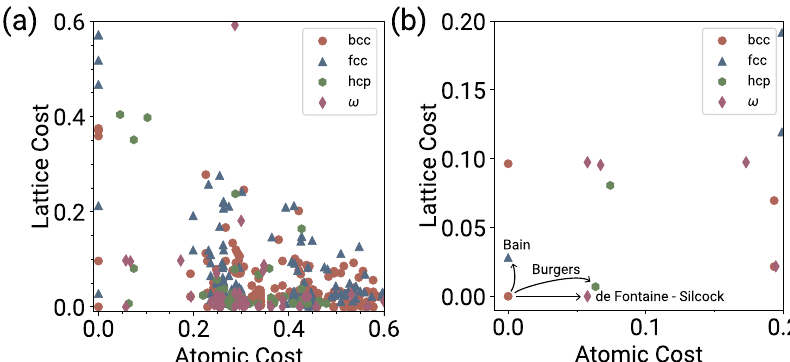
Fig. 5 Mapping costs of common structures onto bcc. The lattice and atomic costs when mapping bcc, fcc, hcp, and ω onto a reference bcc crystal structure. a Most mappings have large mapping costs. b Several well-known transformations, such as the Bain, Burgers, and de Fontaine-Silcock path, have smaller mapping costs.